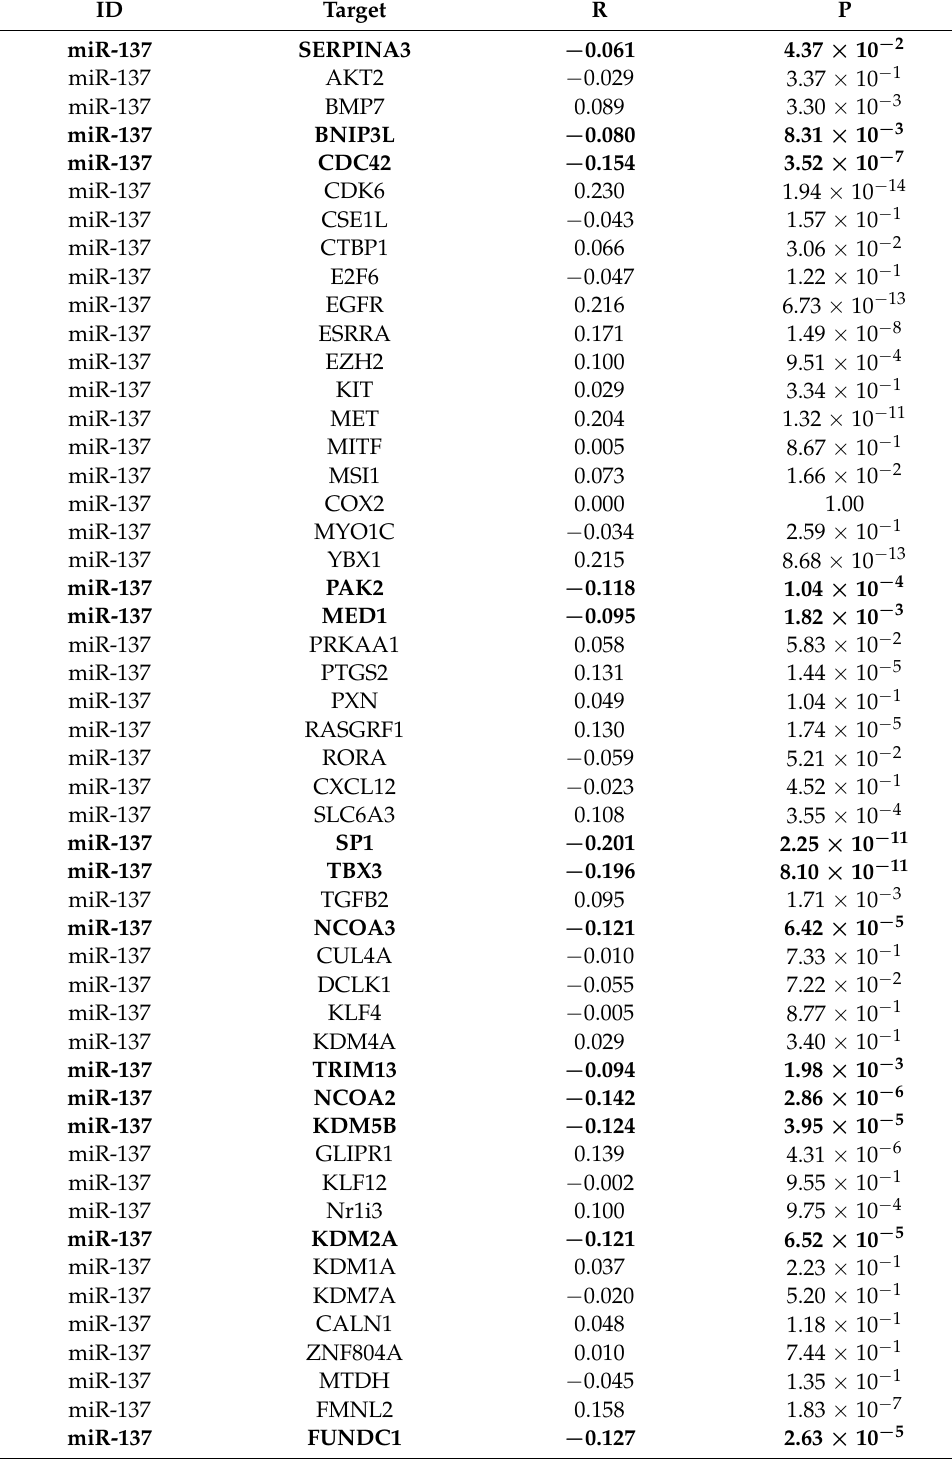
Table 1. The expression correlation of miR-137 with its predicted binding target genes in breast cancer determined by